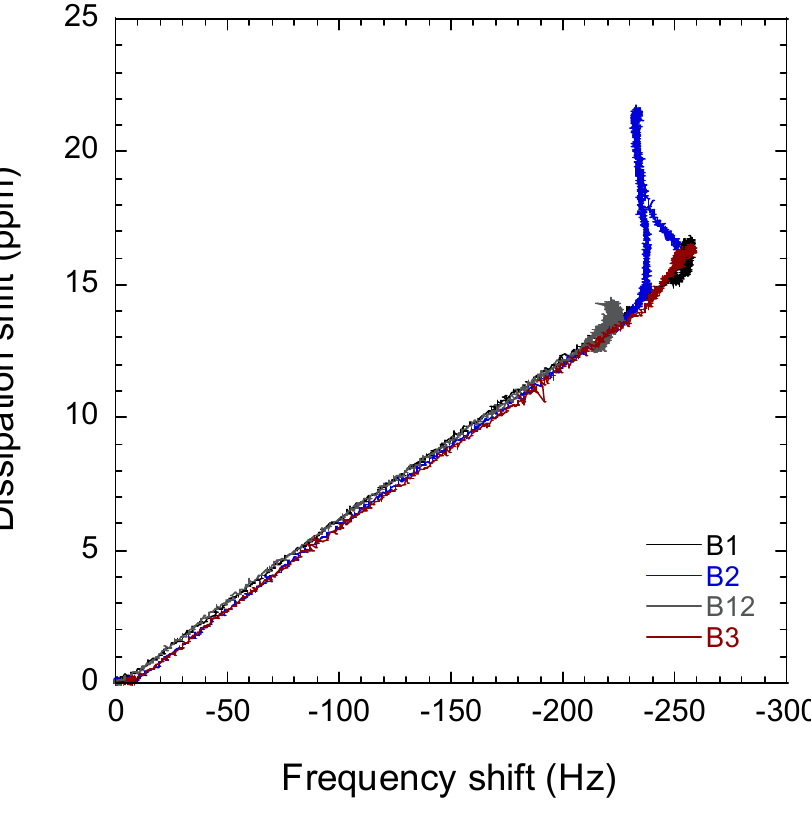
Figure 2. Dissipation shift–Frequency shift ( ∆ D − ∆ F) plot of QCM-D for the generation of the BNC films and the adsorption of the vitamins.